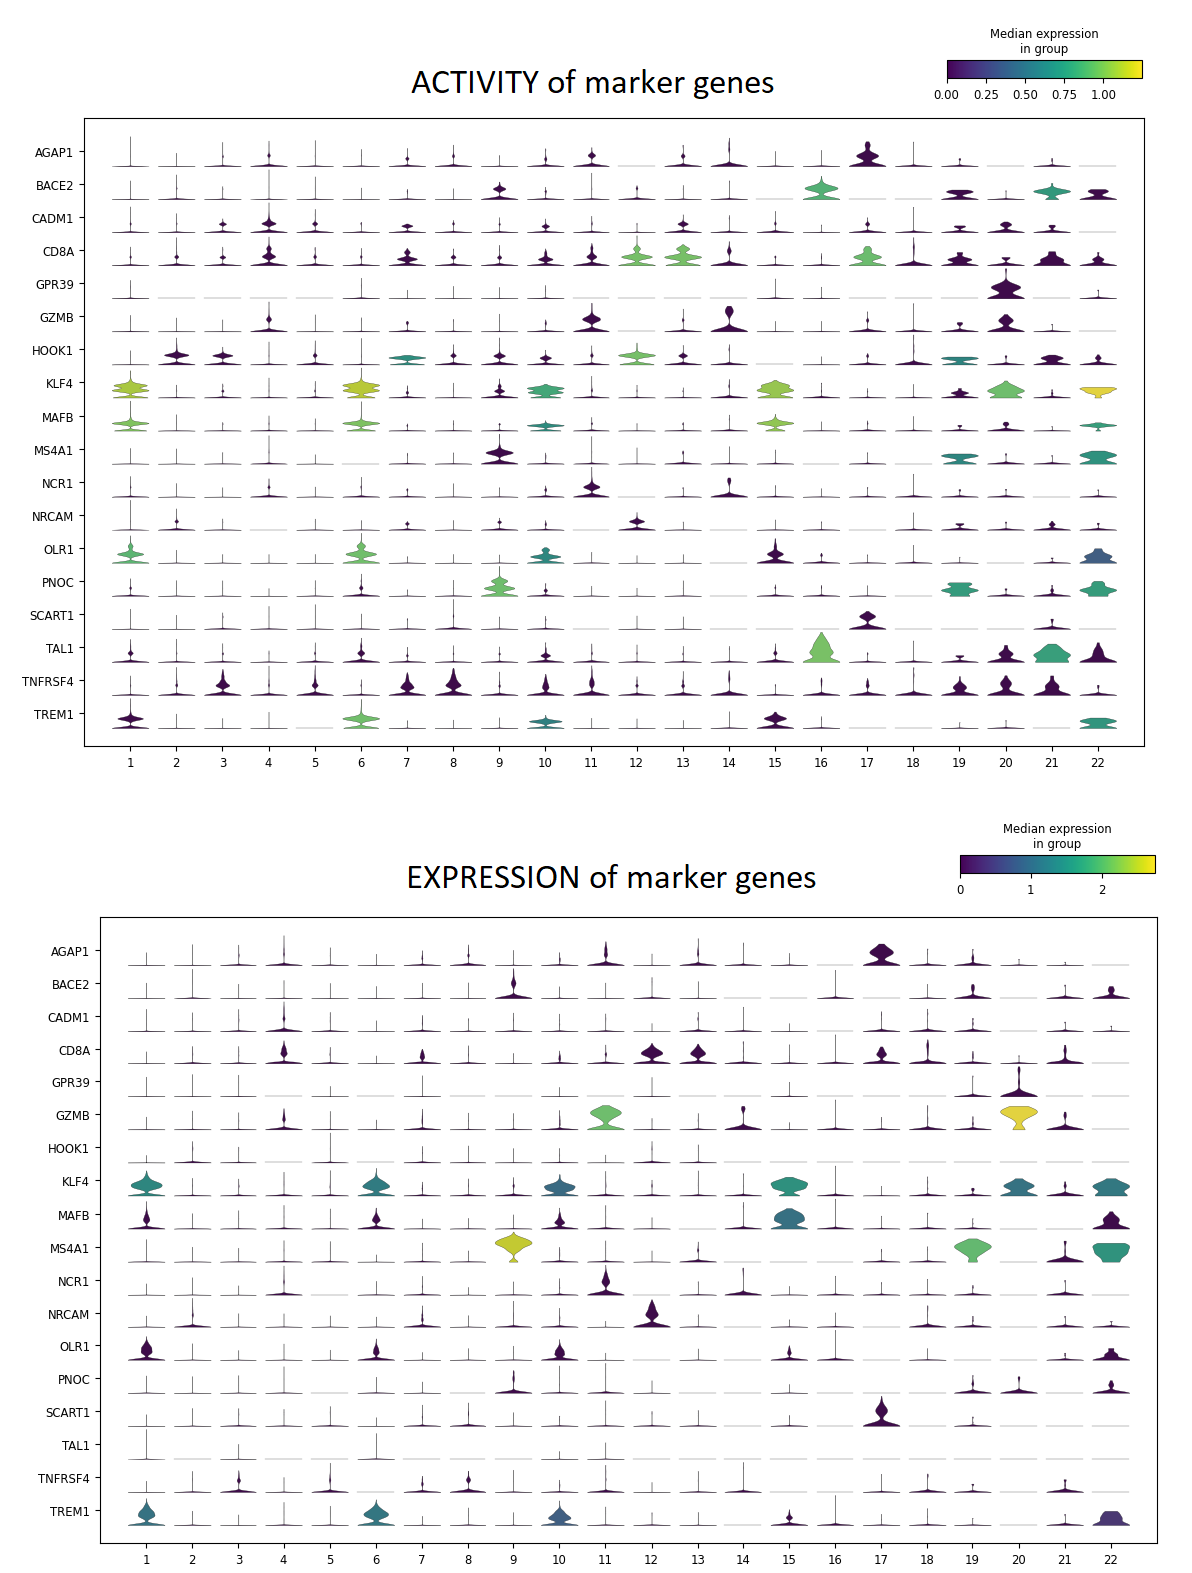
Figure 9. Violin Plots for the top DA genes for each cluster, of their Activity (on the top ) and Expression (on the bottom ), for the 10X Multiome Controller PBMC dataset. The two figures show a general coherence (especially for genes like MS4A1, AGAP1, and KLF4) between the activity and expression profiles on the same cells, showing consistency between the two biological